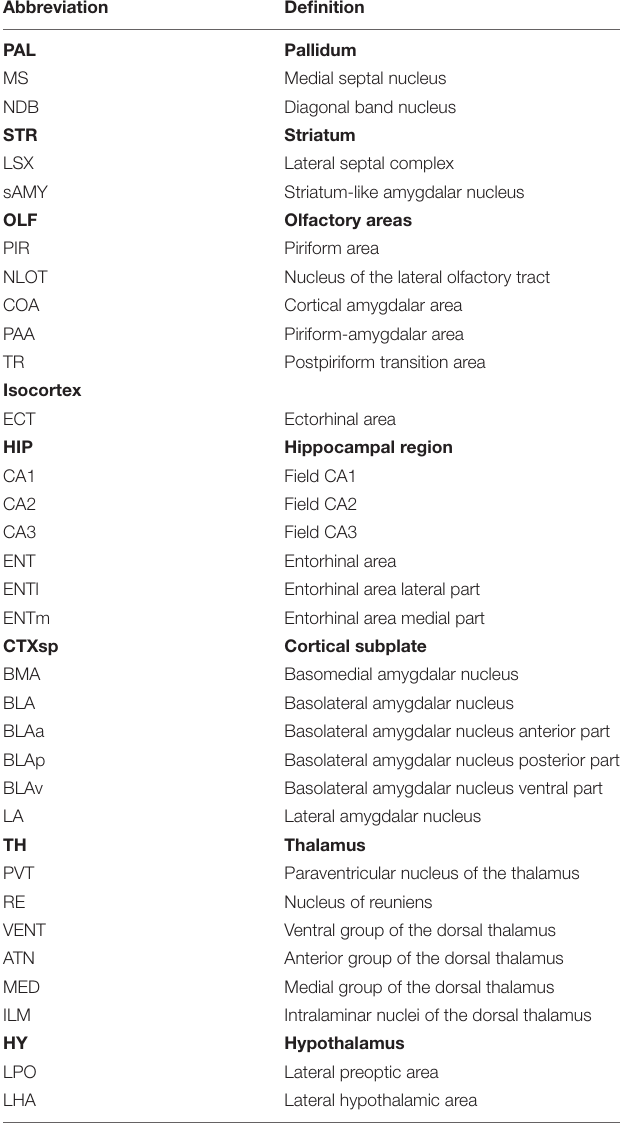
The bold terms and normal terms in Table 1 stand for brain regions and subregions,